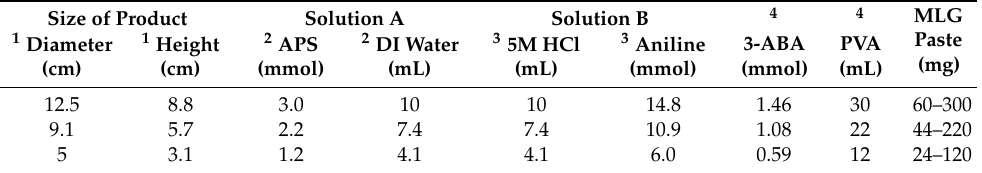
Table 1. Synthetic conditions of PVA-PANI HDGs with di ff erent